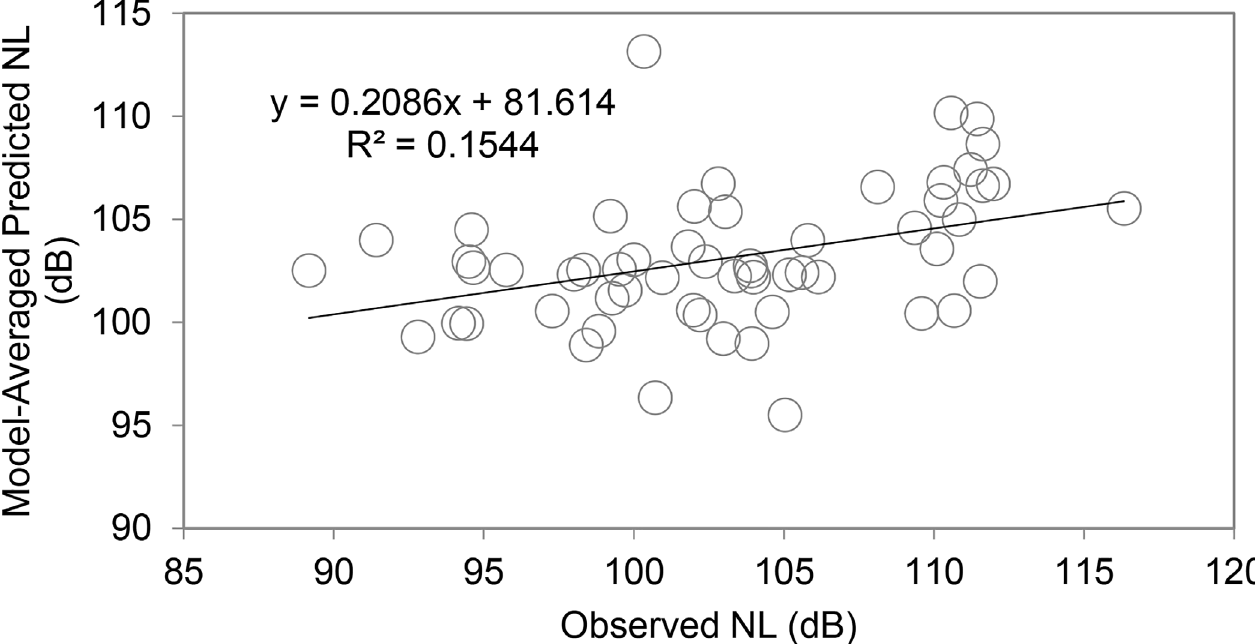
Fig 3. Model predictions vs. observed noise levels, all intervals. Model-averaged predicted noise levels compared to observed noise levels (for all complete intervals, including research vessel-only intervals, n = 57). About 15% of the variation in observed noise levels was explained by the multi-model inference.